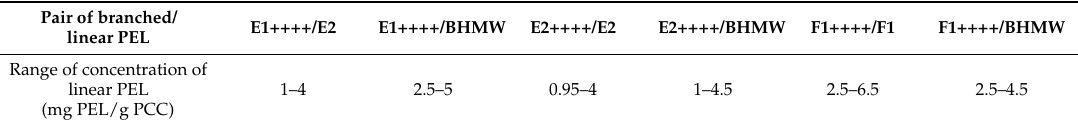
Table 2. Range of concentrations of linear polyelectrolytes tested in re-flocculation when the linear PEL is added after floc break-up.